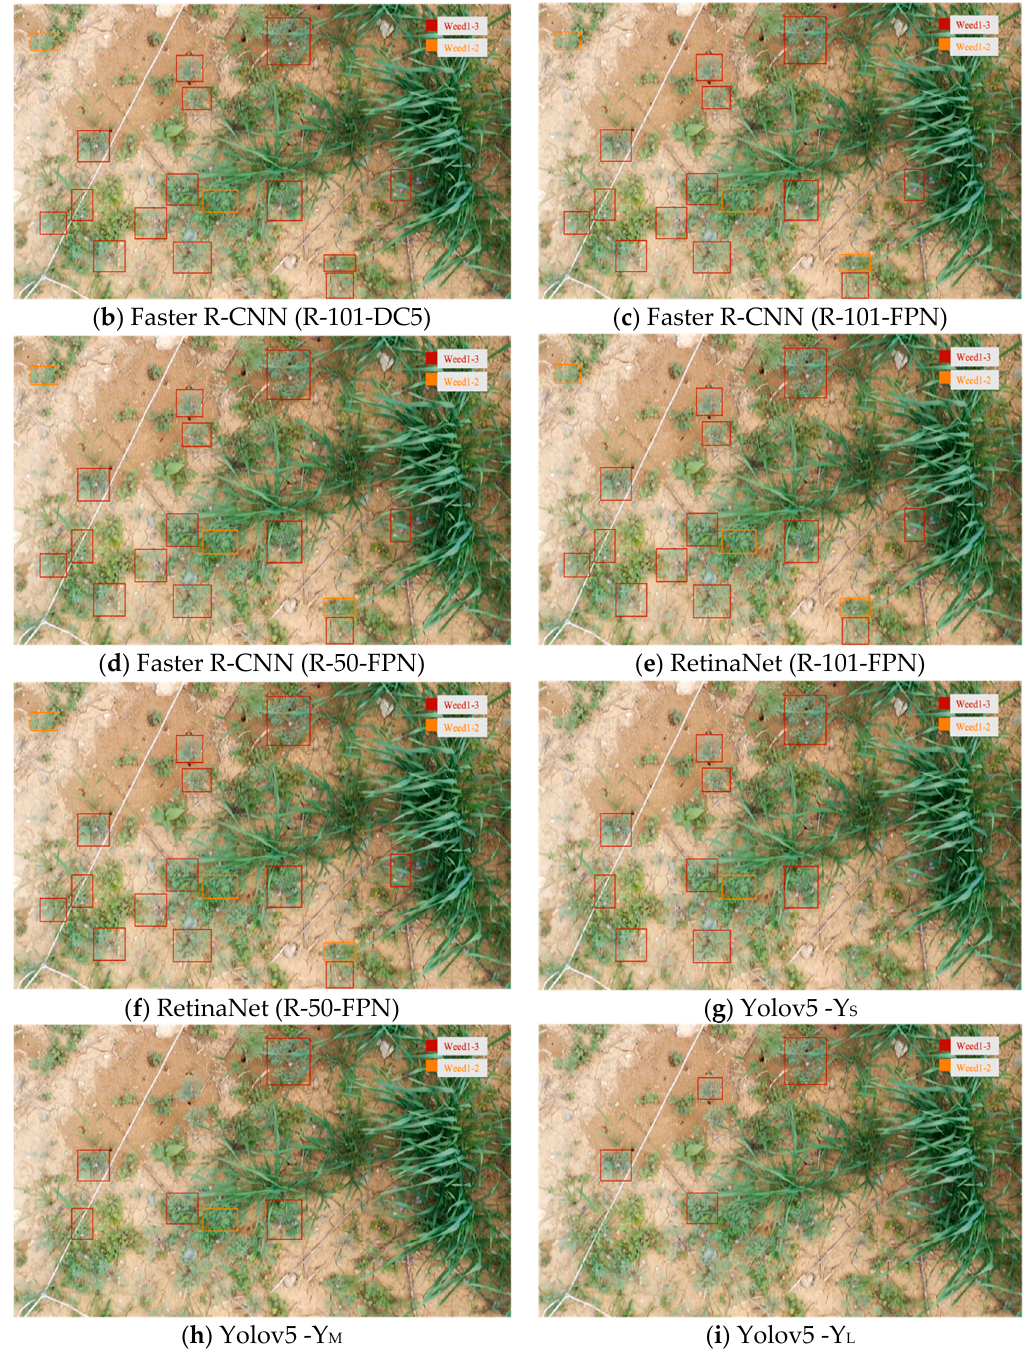
Figure 9. Sample image from detection using ( a ) Ground Truth Labels, ( b ) Faster R-CNN (R-101- DC5), ( c ) Faster R-CNN (R-101-FPN), ( d ) Faster R-CNN (R-50-FPN), ( e ) RetinaNet (R-101-FPN), ( f ) RetinaNet (R-50-FPN), ( g ) Y S , ( h )Y M , and ( i )Y L .